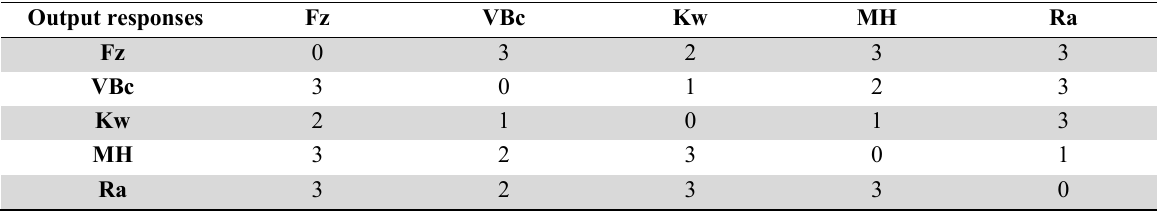
Formulated initial direct-relation matrix Output